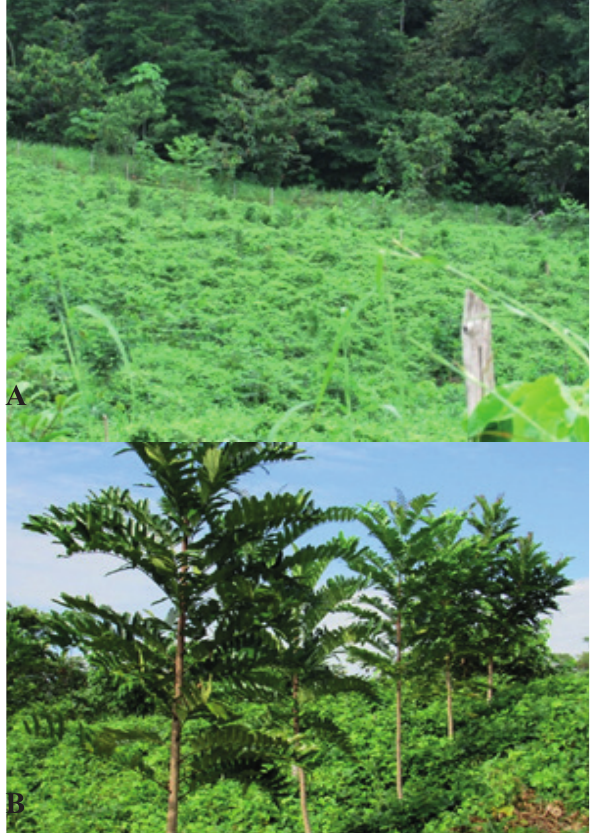
Figure 7. Recovered degraded pasture with Centrosema (A), and trees (B) in agroforestry forestry systems.